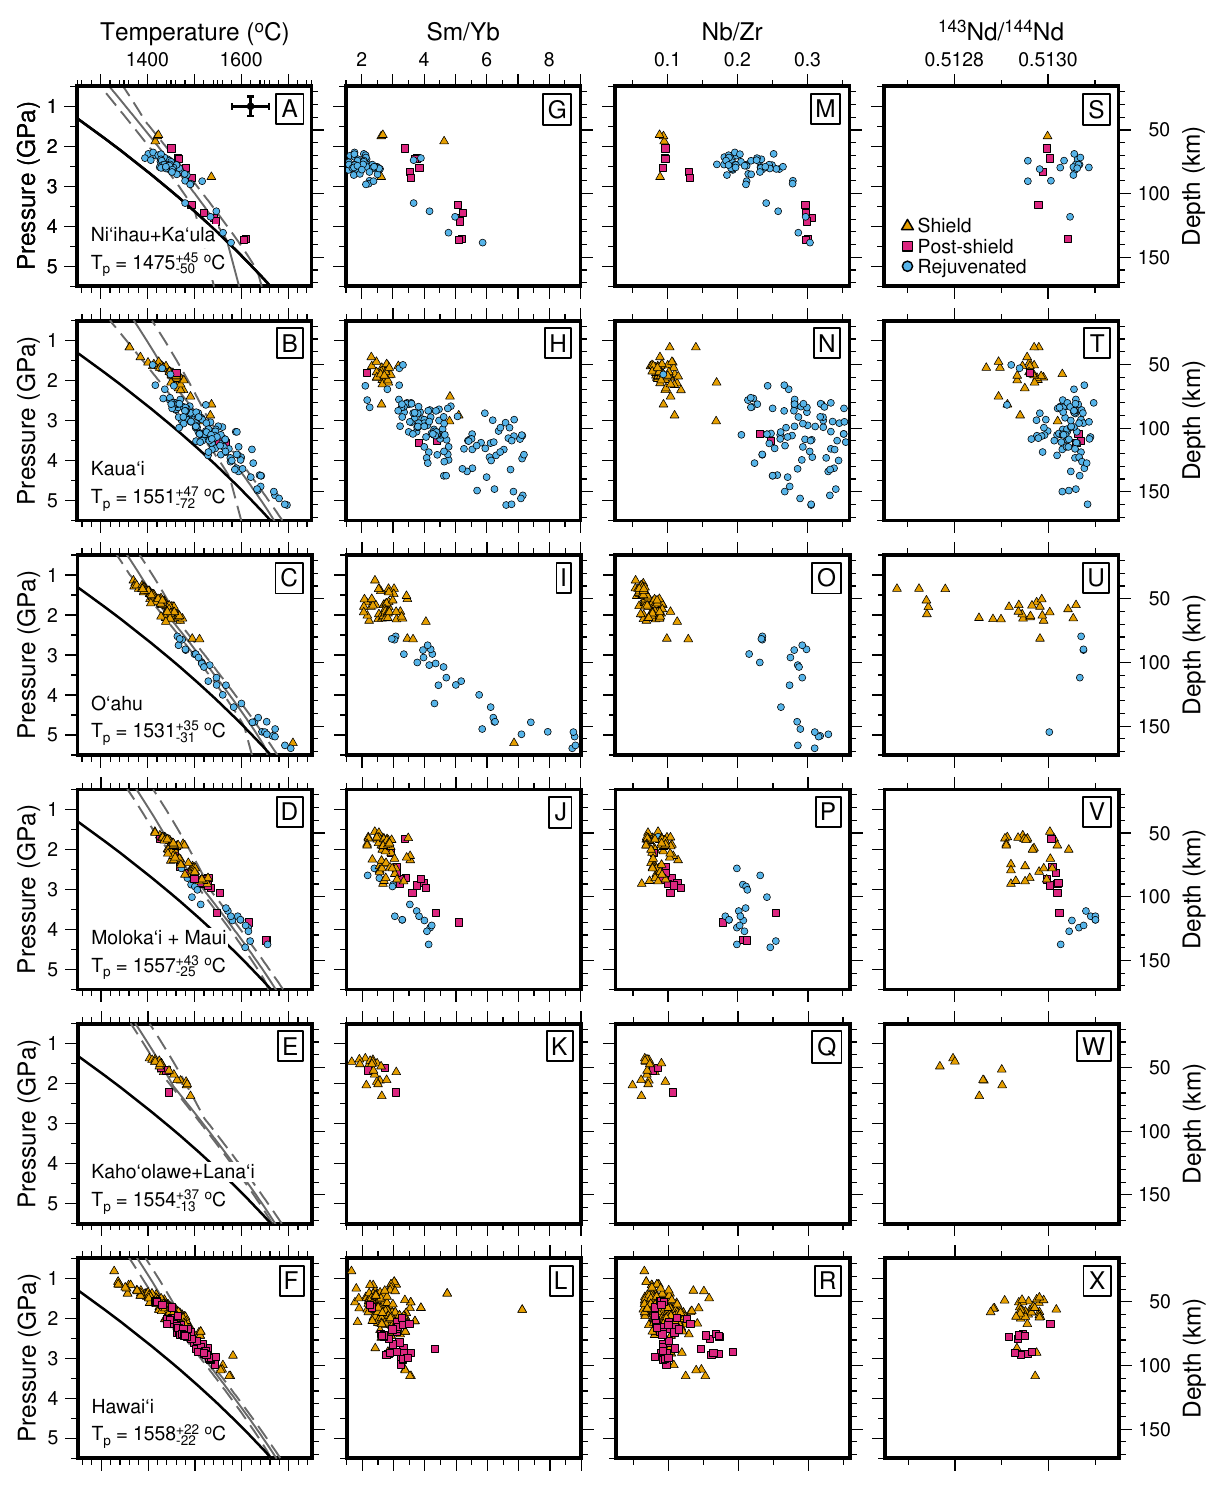
Figure 5: [A] Temperature plotted as function of depth/pressure. Symbols = equilibration pressure/temperature estimates de- termined for mafic samples from Ni ‘ ihau and Ka ‘ ula using formulation of Plank and Forsyth [2016] and parameters in Table 2. Orange/pink/blue symbols = shield/post-shield/rejuvenated phase data. Black line = anhydrous solidus; gray line = best-fitting melt pathway; dashed gray lines = minimum and maximum melt pathways for which misfit value at global minimum is double [Katz et al. 2003]; optimal value of T p = 1475 +45 °C. Black point with error bars in top right displays the errors associated with this − 50 thermobarometric method [39 °C, 0.24 GPa; Plank and Forsyth 2016]. [B] Kaua ‘ i. [C] O ‘ ahu. [D] Moloka ‘ i and Maui. [E] Kaho ‘ olawe and L¯ana ‘ i. [F] Hawai ‘ i. [G]–[L] Same as Panels [A]–[F] but with Sm/Yb ratios plotted as function of calculated pressures. [M]–[R] Same as Panels [A]–[F] but with Nb/Zr ratios plotted as function of calculated pressures. [S]–[X] Same as Panels [A]–[F] but with 143 Nd/ 144 Nd ratios plotted as function of calculated